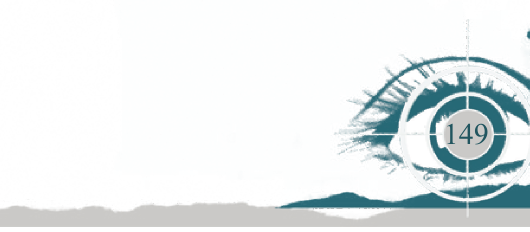
Figure 6. The percentages of respondents within each gender who gave correct answers to questions 7-11. The percentages of the respondents who provided the correct answers among those who responded to each question are shown as